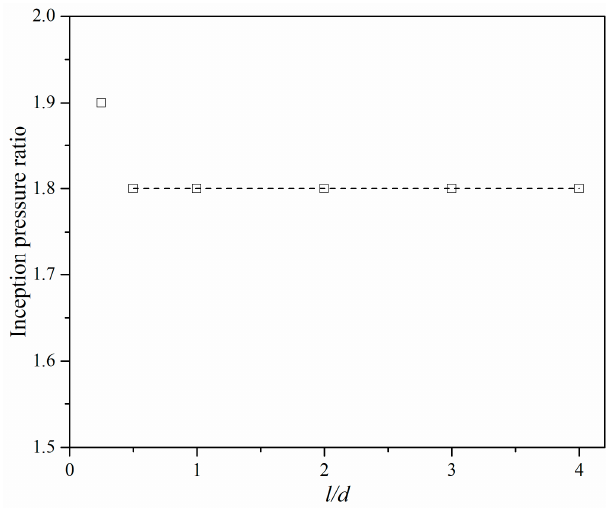
Figure 10. Pressure ratio vs. ratio between length and diameter at cavitation inception.